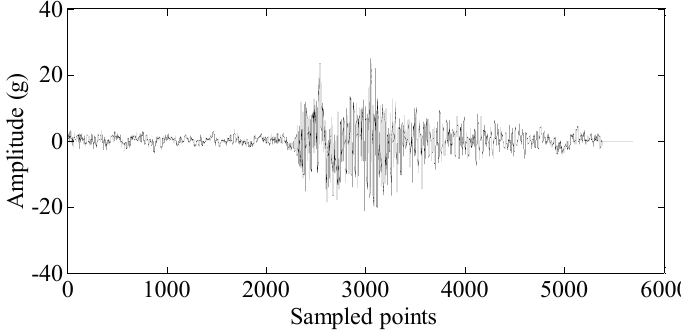
Figure 2. Combustion segment from a cylinder vibration signal.